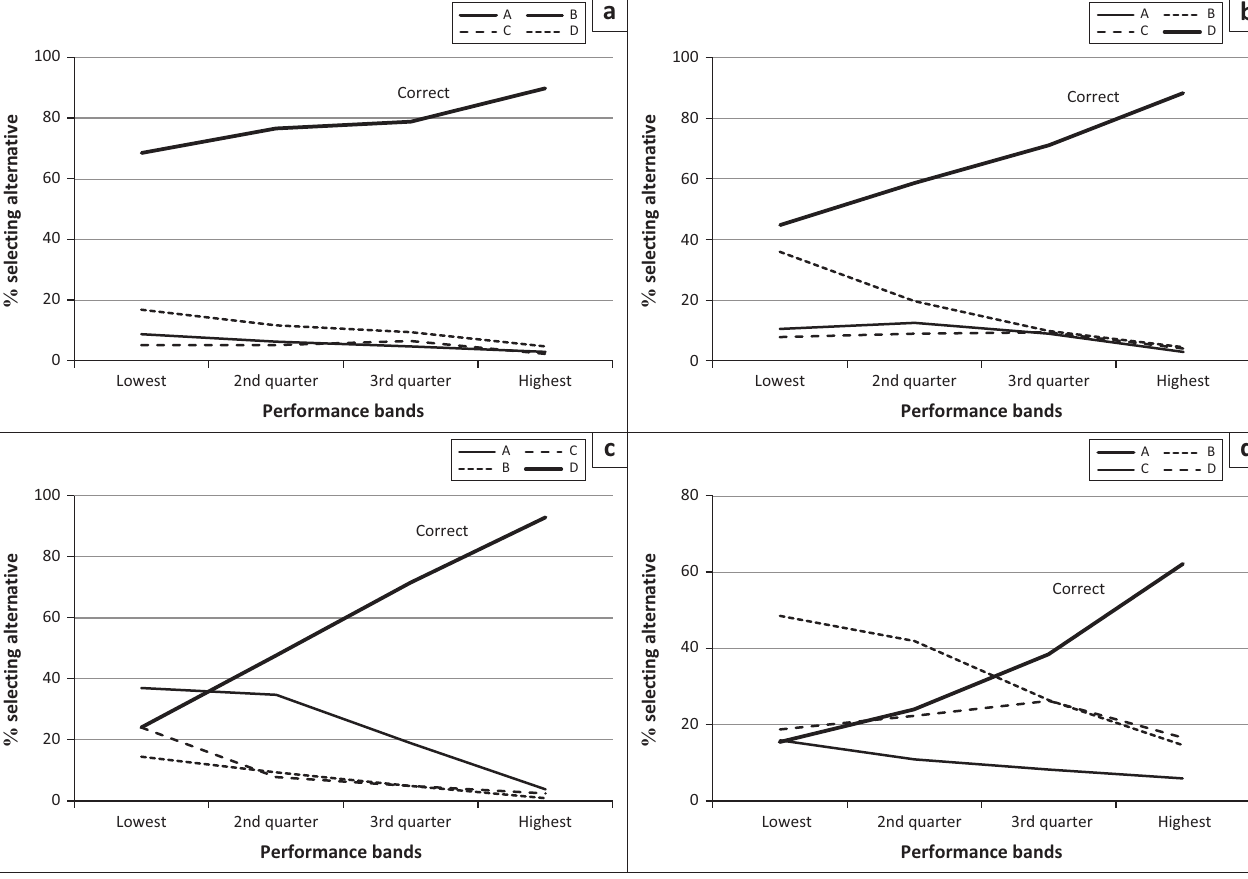
FIGURE 2: Results for comparison problems requiring the comparison of the rates, by performance